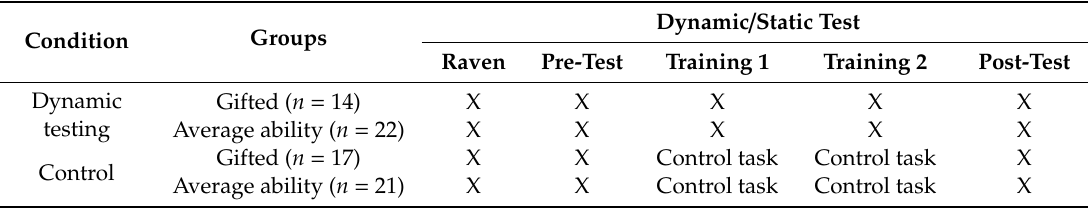
Table 1. Overview of the